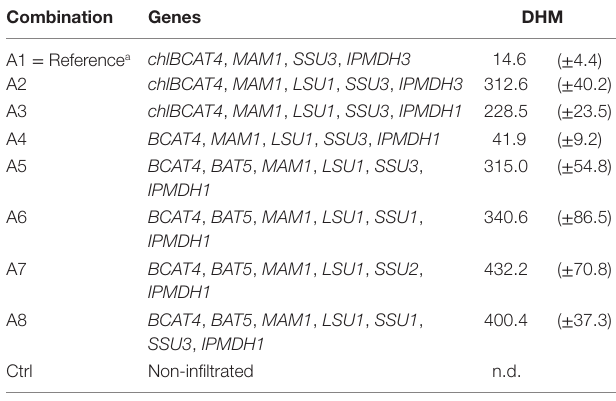
TaBle 1 | Optimization of DhM production in N. benthamiana